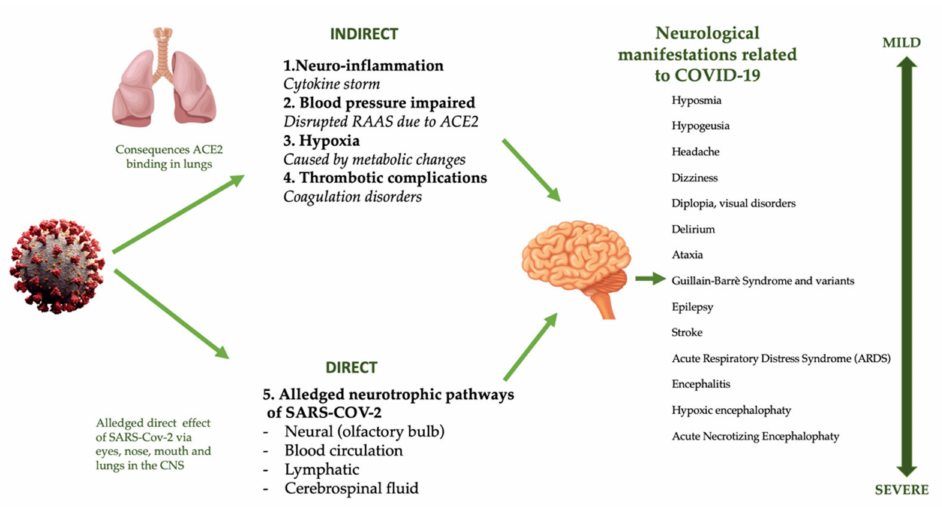
Figure 4. Direct and indirect mechanisms of COVID-19 CNS damage. Abbreviations: ACE2, angiotensin-converting enzyme 2; CNS, central nervous system; RAAS, renin-angiotensin aldosterone system; SARS-CoV-2, severe acute respiratory syndrome coronavirus